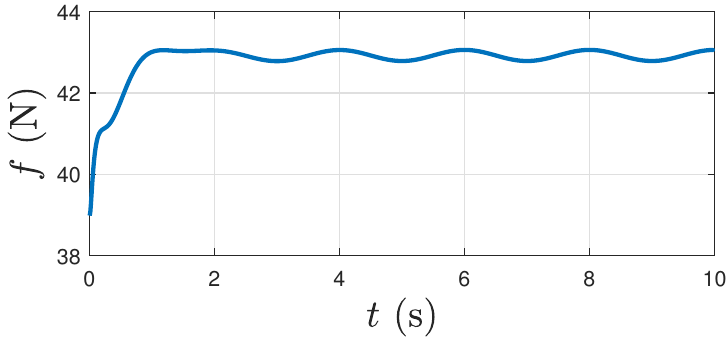
Figure 6. Thrust magnitude versus time.